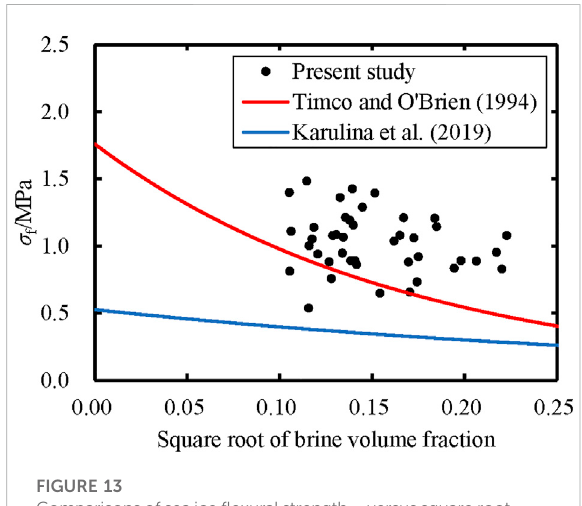
FIGURE 13 Comparisonsofsea ice fl exural strength σ f versussquare root of brine volume fraction between different